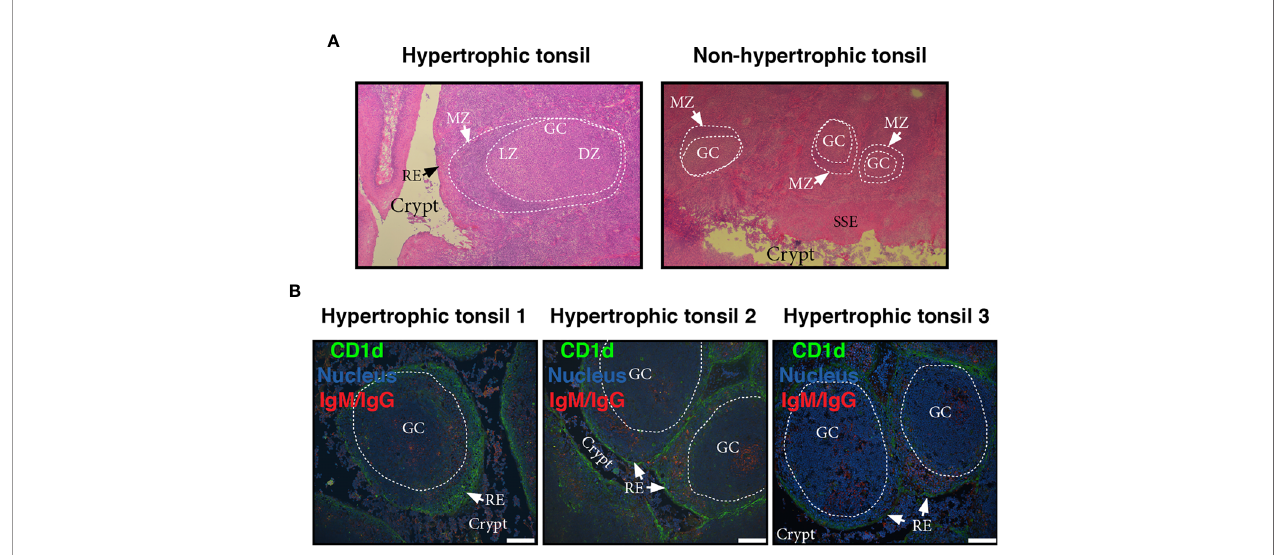
FIGURE 4 | Microscopic features of germinal centers from hypertrophic tonsils. (A) Comparative light microscopy of GC from an hypertrophic tonsil (left) and a non- hypertrophic tonsil (right) which evidence the difference in size largely documented in literature. H.E, original magni fi cation 40x. MZ of the follicles is indicated by white arrows. LZ stands for light zone and DZ stands for dark zone. RE and SSE are also denoted in the pictures. (B) Three colour immuno fl uorescence staining showing GC from tonsils excised from three different OSA patients (1, 2, 3, see also colour code). Note the lymphoid hyperplasia, the degree of in fi ltration of the reticular epithelium (RE) in all cases, and the crypts invaded by lymphoid cells (most B and plasma cells according to staining). Scale bar, 100 µm. Samples were examined with a Nikon Eclipse Ti-E microscope.